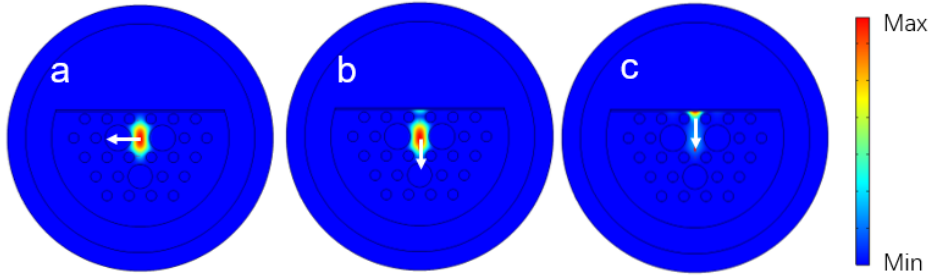
Figure 2. Mode patterns of fundamental modes (FMs) and plasmonic mode: ( a ) x-polarization core FM; ( b ) y-polarization core FM; ( c ) surface-plasmon-polariton (SPP) mode in sensing layer.